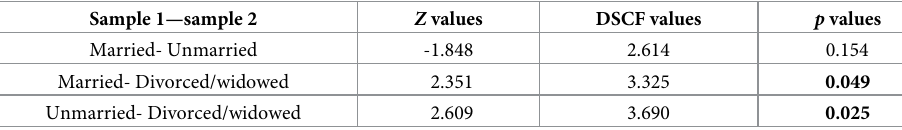
Table 3. Influence of different marriages on stigma of COVID-19 patients.